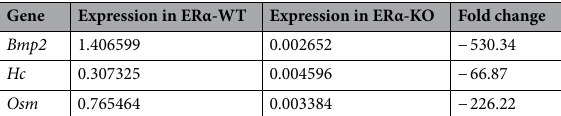
Table 1. Down regulated genes in ERα-KO muscle.